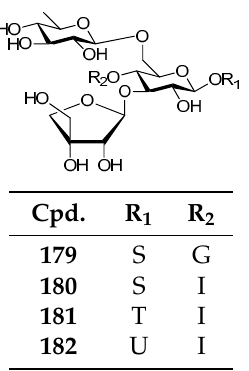
Figure 23. Structure of compound 178 . Cpd.